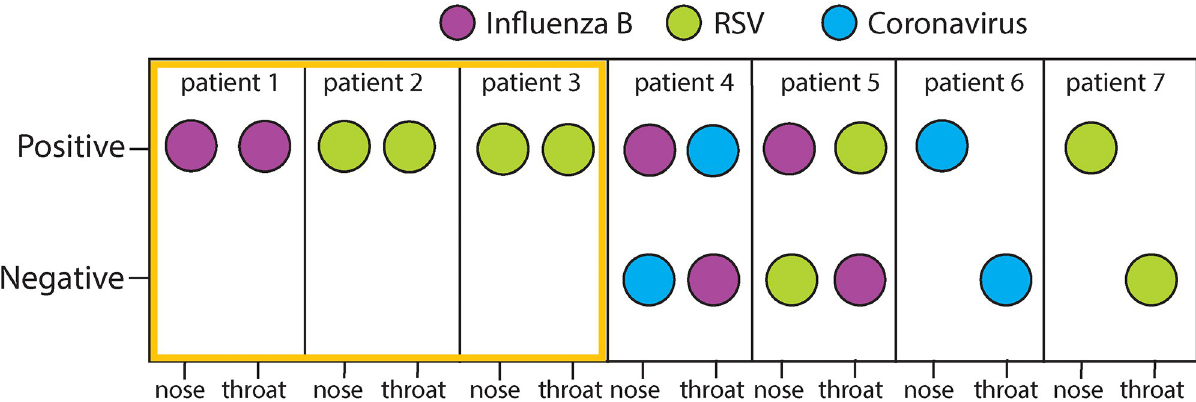
Fig 2. Summary of nose and throat comparison using shotgun RNA sequencing. Nose and throat samples were analyzed separately in 22 individuals. Seven out of 22 individuals were positive in at least one of the samples. The same virus was detected in both types of samples in 3 individuals (orange box). The other 5 individuals showed differences between viruses detected in the nose versus the